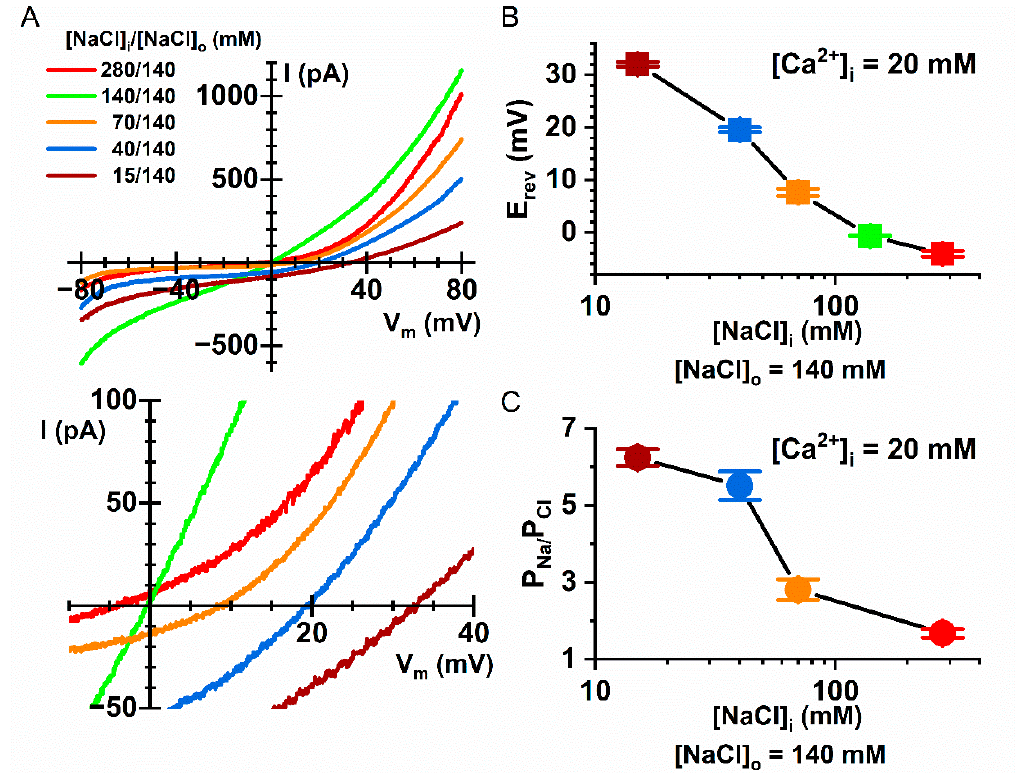
Figure 10. Dependence of the P Na /P Cl ratio of Q559W 16F on [NaCl] i . ( A ) Representative I–V curves for Q559W 16F in various [NaCl] i (from 15 to 280 mM). In all recordings, [NaCl] o = 140 mM and the currents were activated by 20 µM [Ca 2+ ] i . The same I–V curves expanded around the E rev are shown in the bottom panel. ( B ) Averaged E rev as a function of [NaCl] i from the recordings like those shown in A. ( C ) P Na /P Cl ratio as a function of [NaCl] i . Note the reduction of the P Na /P Cl ratio as [NaCl] i increases ( n = 6–22).